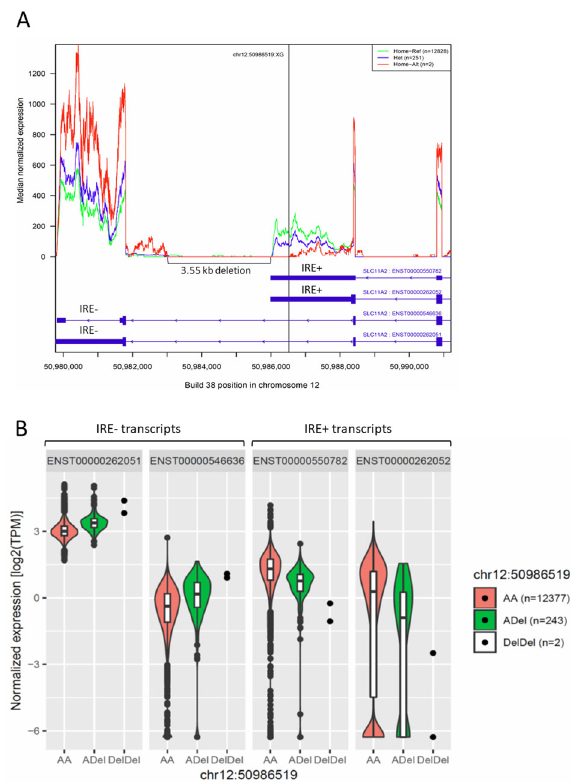
Fig. 6 Expression levels of SLC11A2 for novel deletion mutant compared to wild type. A Coverage plot of RNA-sequenced reads from whole blood showing the median normalized expression at the 3 ′ UTR end of SLC11A2 in wild-type (AA, green; n = 12,828) heterozygous (ADel, blue; n = 251) and homozygous (DelDel, red; n = 2) individuals for the different SLC11A2 deletion genotypes. B Comparison of expression levels of the four major SLC11A2 transcripts (two transcripts without iron response elements (IRE) in their 3 ′ UTR (IRE-) and two with IRE (IRE + ) in their 3 ′ UTR in whole blood RNA using a mixed violin- and boxplot. The violin plot shows the density where the width represents the frequency of the log2 normalized expression levels. The white boxes show the distribution statistics (interquartile range and median) and the whiskers represent ±1.5× the interquartile range. The fi lled circles correspond to individual expression values or outliers that lie beyond the extremes of the